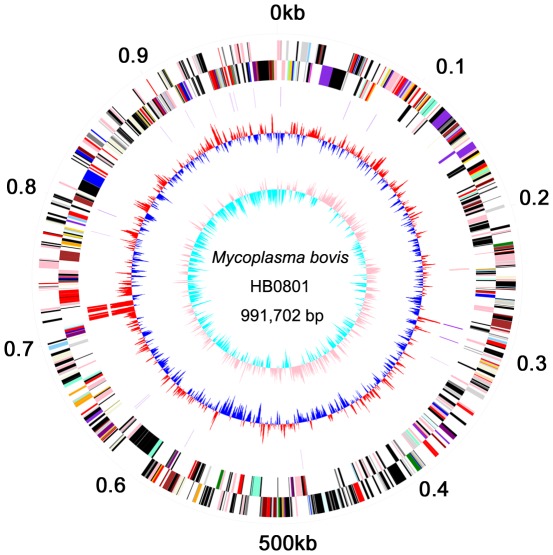
Circular Diagram of the M. bovis HB0801 Genome Structure.The dnaA gene is at position zero. Starting from the outside, the first circle shows the genome length (units in Mb); the second and the third circles show the locations of the predicted CDSs on the plus and minus strands, respectively, which were color-coded by COG categories (gold for translation, ribosomal structure and biogenesis; orange for RNA processing and modification; light orange for transcription; dark orange for DNA replication, recombination and repair; antique white for cell division and chromosome partitioning; pink for defense mechanisms; red for signal transduction mechanisms; peach for cell envelope biogenesis and outer membrane; deep pink for intracellular trafficking, secretion and vesicular transport; pale green for post-translational modification, protein turnover and chaperones; royal blue for energy production and conversion; blue for carbohydrate transport and metabolism; dodger blue for amino acid transport and metabolism; sky blue for nucleotide transport and metabolism; light blue for coenzyme metabolism; cyan for lipid metabolism; medium purple for inorganic ion transport and metabolism; aquamarine for secondary metabolites biosynthesis, transport and catabolism; and gray for unknown function); the fourth circle shows tRNAs (violet) and rRNAs (red); the fifth circle shows the centered GC (G+C) content of each CDS (red: above mean and blue: below mean); and the sixth circle shows the GC (G+C) skew plot.